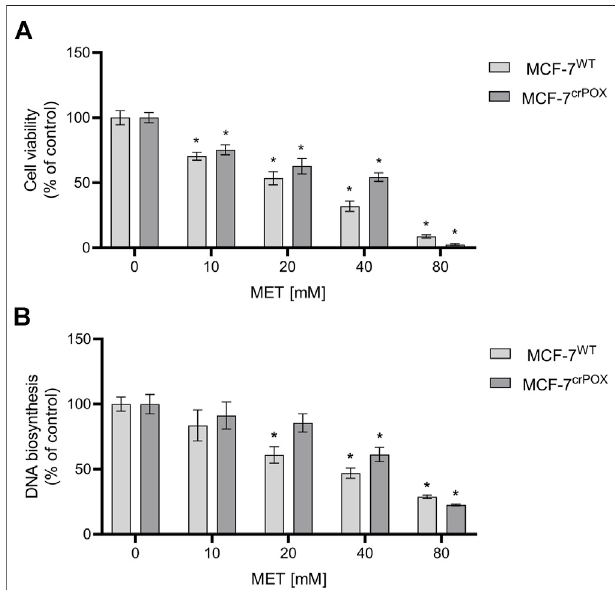
FIGURE 1| Cell viability (A) and DNA biosynthesis (B) in wild-type MCF- 7 cells (MCF-7 WT ) and knocked-down PRODH/POX MCF-7 cells (MCF- 7 crPOX ) upon treatment with indicated concentrations of metformin (MET) for 48 hinglutamine-freemedium.Themeanvalueswithstandarddeviation (SD) from three experiments performed in duplicates are presented. Asterisks (*) indicate statistical differences between studied cells compared to controls at p <